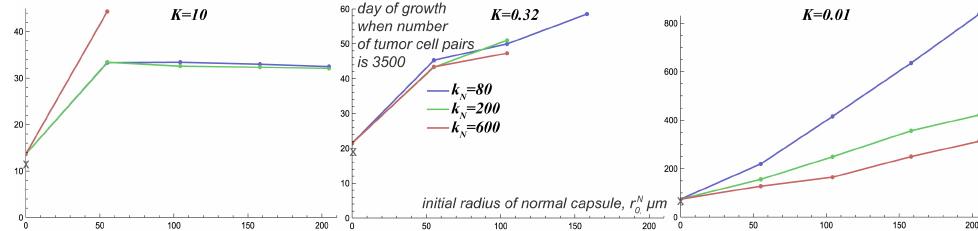
Figure 7. The times when the number of tumor cell pairs reached 3500 for encapsulated tumor growth in normal tissue without accounting for nutrients depending on the initial radius of the normal capsule r 0 for variations in the coefficient of stress function for normal cells k N and tissue N conductivity K . The coefficient of stress function for tumor cells k T = 80 and the values of the other parameters are indicated in Tables 1 and 2. The absence of points for certain values of r 0 that the tumor did not grow under certain parameter values. Crosses on ordinate axes denote the analogous moments for free tumor